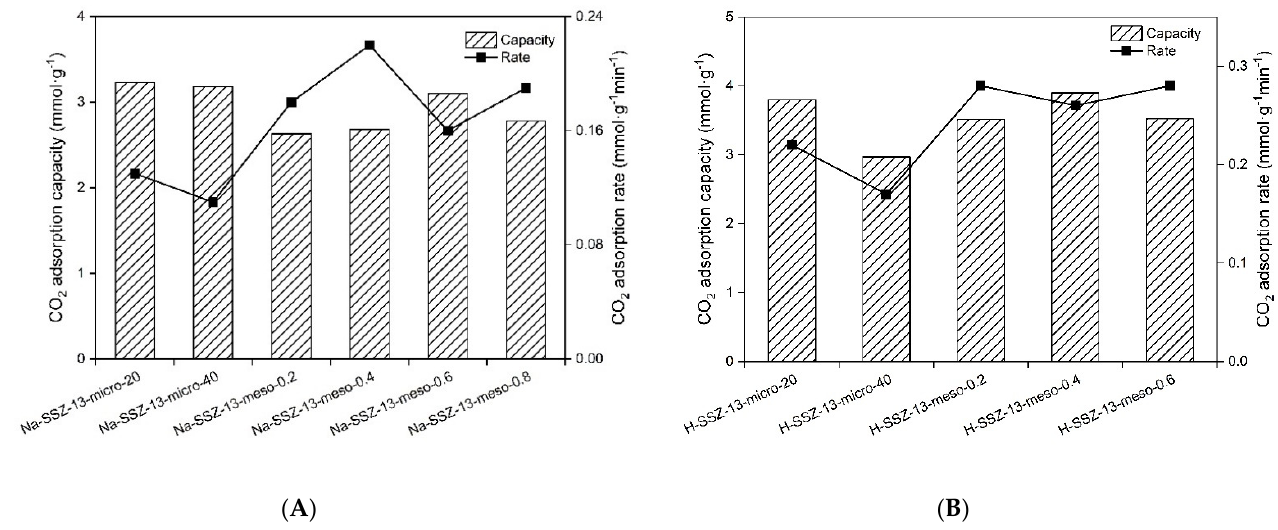
Figure 8. CO 2 adsorption capacity and adsorption rate in ( A ) Na ‐ SSZ ‐ 13 materials; ( B ) H ‐ SSZ ‐ 13 materials.